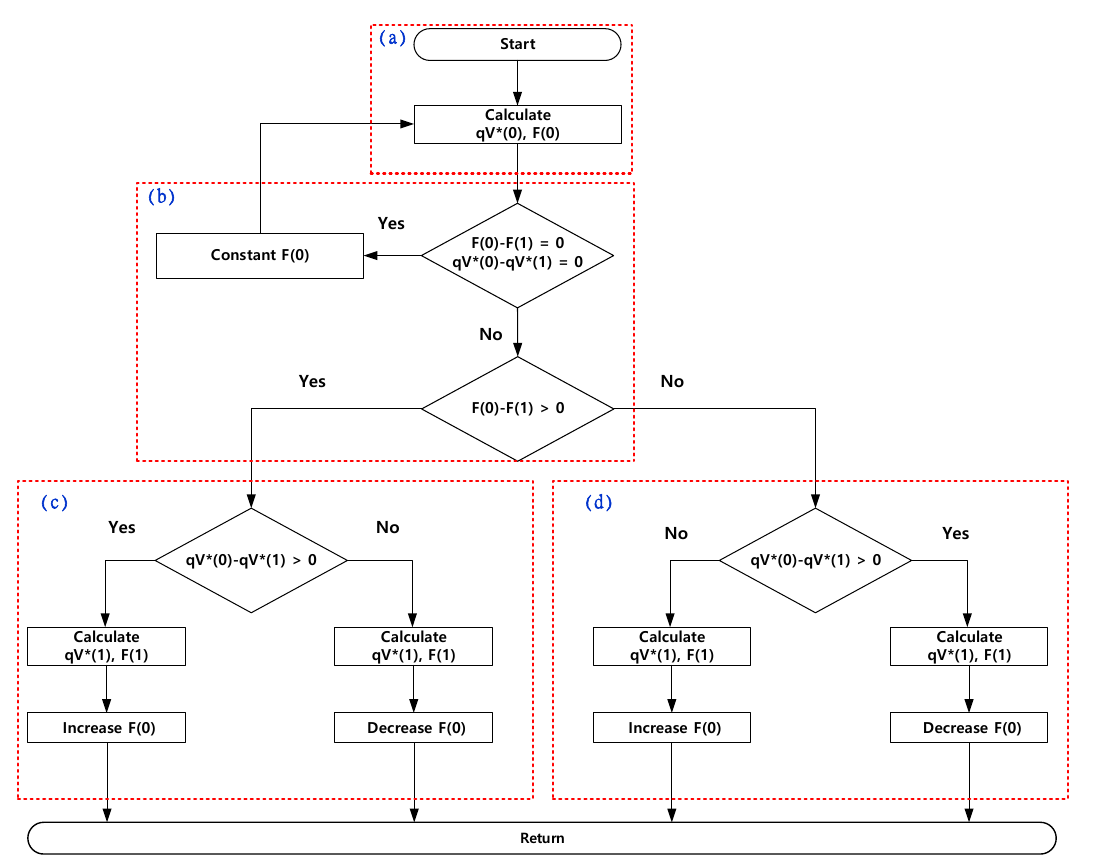
Figure 13. Flow chart of frequency-tracking algorithm.